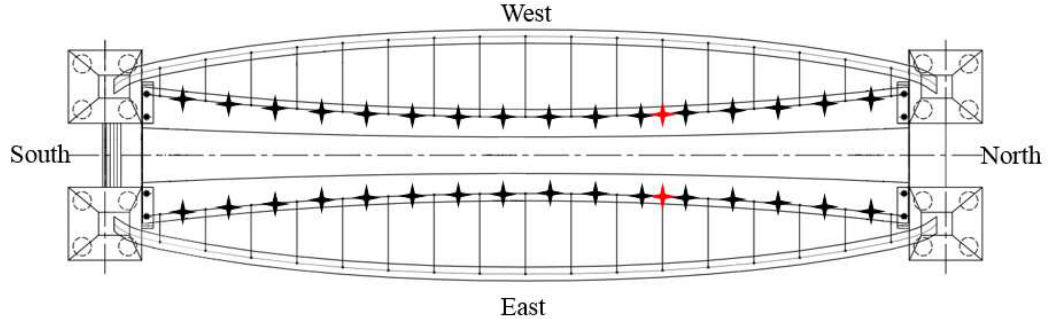
Figure 7. Measured points in the modal test.